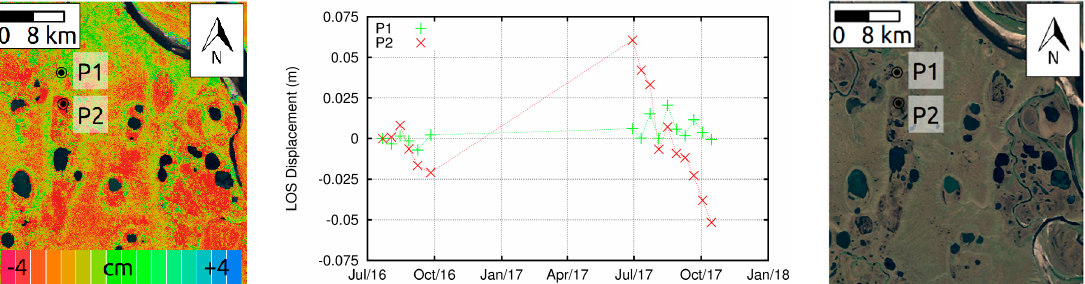
Figure 9. Time series of displacement in the line ‐ of ‐ sight direction over an upland area (P1) and a thermokarst basin (P2) within the same terrace on Kurungnakh Island in the southern central Lena River Delta. For location see Figure 8. Map data are from Google, DigitalGlobe.